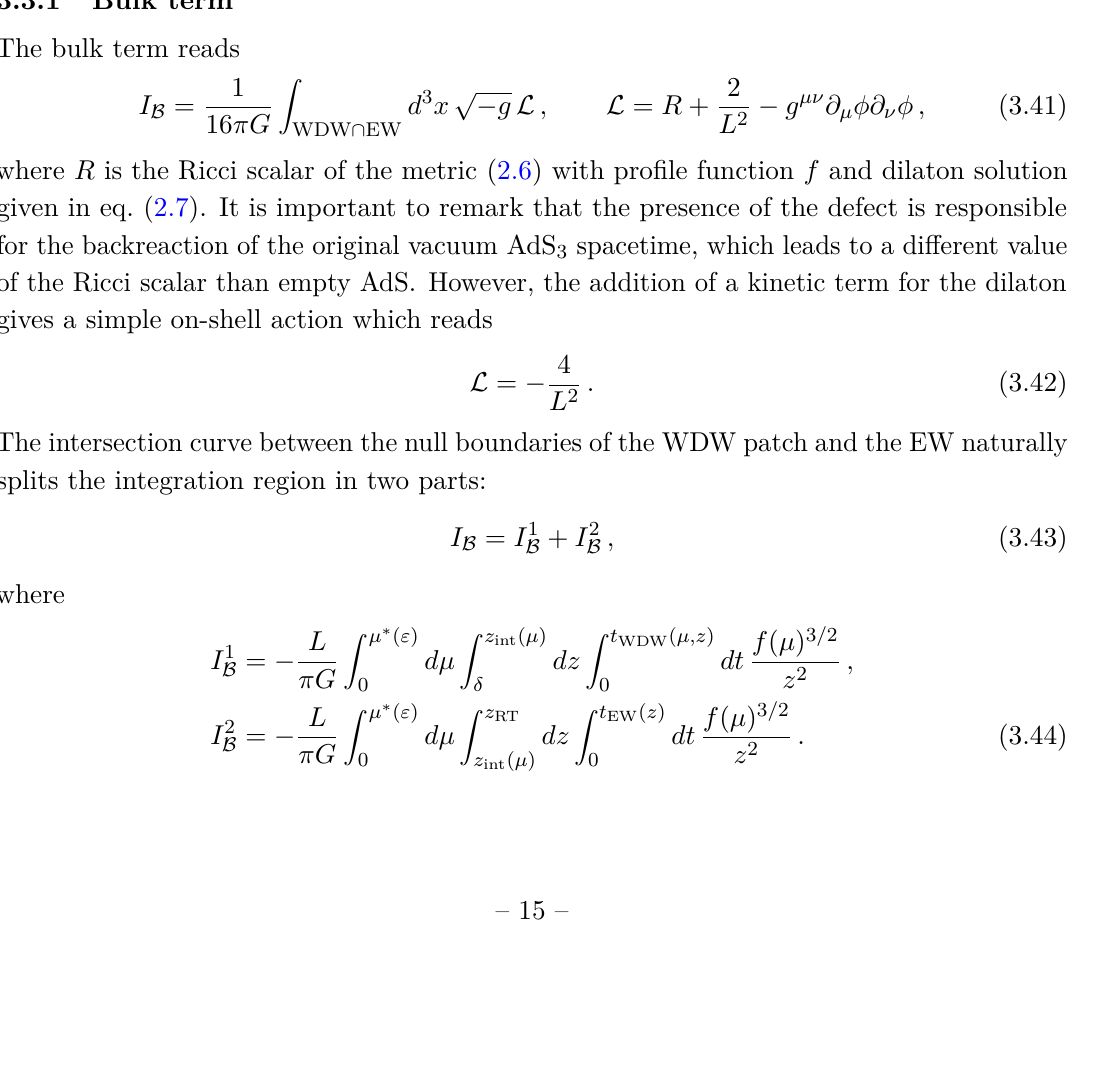
Figure 3 . A pictorial representation of the null boundaries of the WDW patch (light orange surfaces), of the entanglement wedge (red), and the intersection curve z The blue plane restricts the integration region to t ≥ 0 only. The purple transparent region represents the cutoff surfaces located at z = δ and µ = ± µ ∗ ( ε ) . The diagram corresponds to the choice γ = 0 . 5